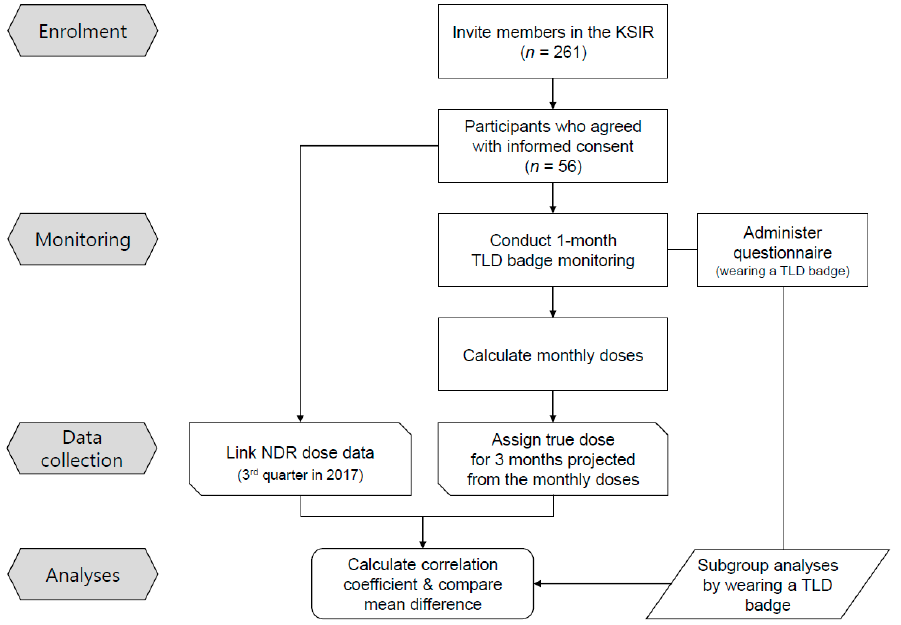
Figure 1. Study flowchart. KSIR, Korean Society of Interventional Radiology; TLD, thermoluminescent dosimeter; NDR, national dose registry.